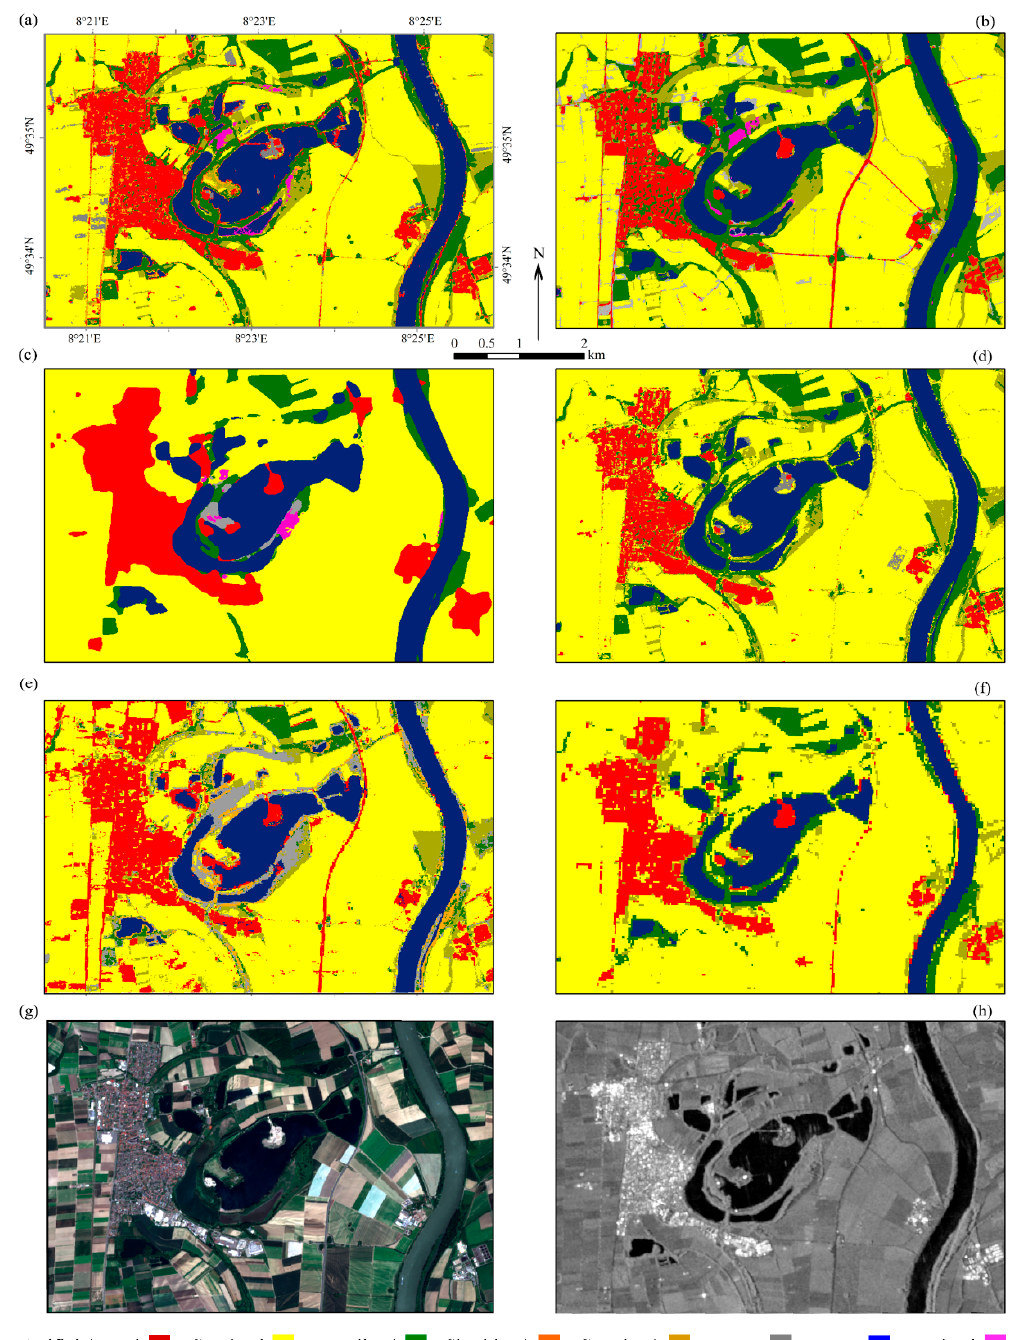
Figure 8. The ( a ) final ELULC 10 m inventory map, ( b ) ESA WorldCover 10 m, ( c ) Esri 2020, ( d ) ELC-10, ( e ) S2GLC, ( f ) FROM-GLC10, ( g ) Sentinel-2 MSI color composite images, and ( h ) Sentinel-1 GRD grayscale of a sample area in Silbersee, Germany.